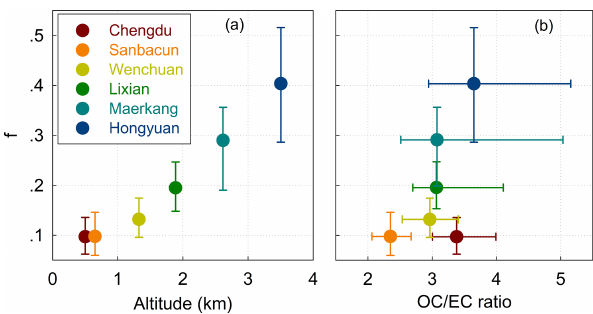
Figure 7. Variation of radiative forcing of BrC relative to EC ( f ; see Eq. 8) as (a) altitude and (b) OC / EC ratio for each site. The solid dots denote the median values, and the two whiskers of the dots denote the 25th and 75th percentiles of the variables.